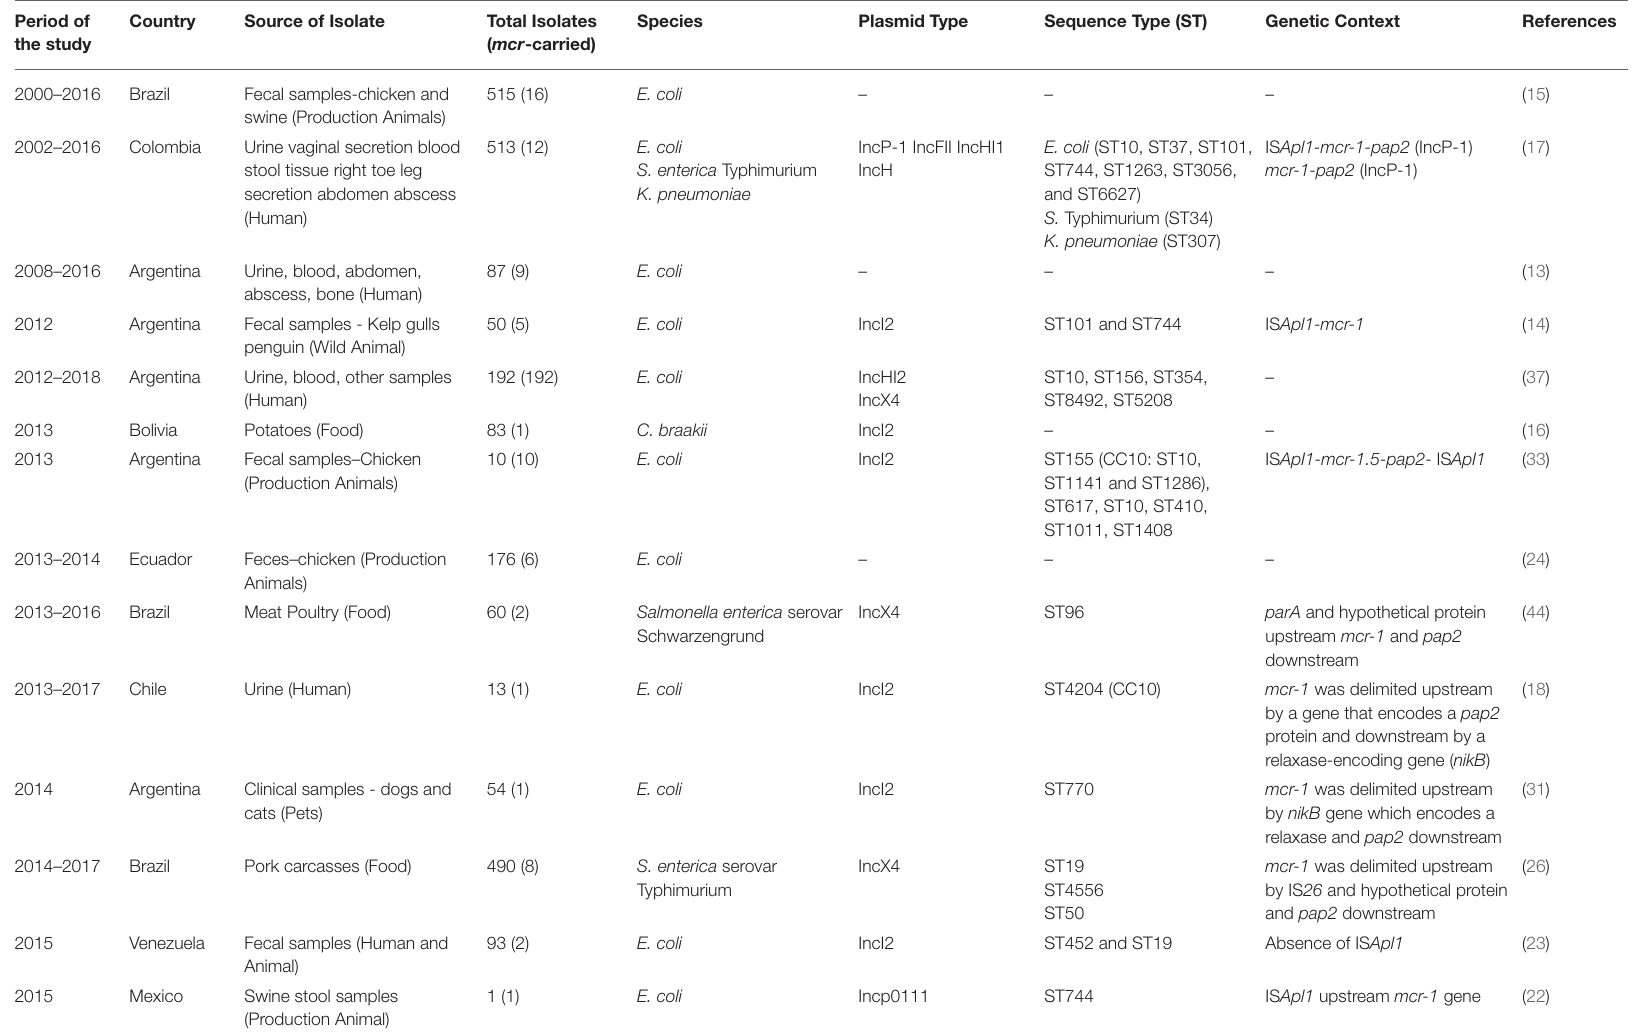
TABLE 1 | Summary of mainly studies reporting mcr-1 gene in Latin America. Period of the